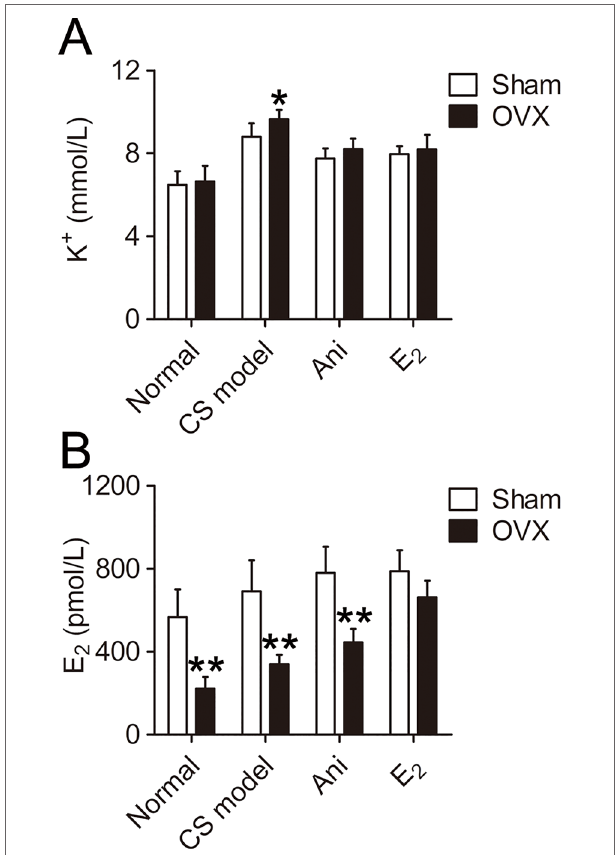
FIgURE 3 | Influences of ovariectomy (OVX) and anisodamine (Ani)/E 2 treatment on serum K + and E 2 in mice with crush syndrome (CS). Ani (28 mg/kg, i.p.) or E 2 (100 mg/kg, i.p.) was administrated at 30 min before decompression in mice with CS 2 weeks after OVX surgery or its sham